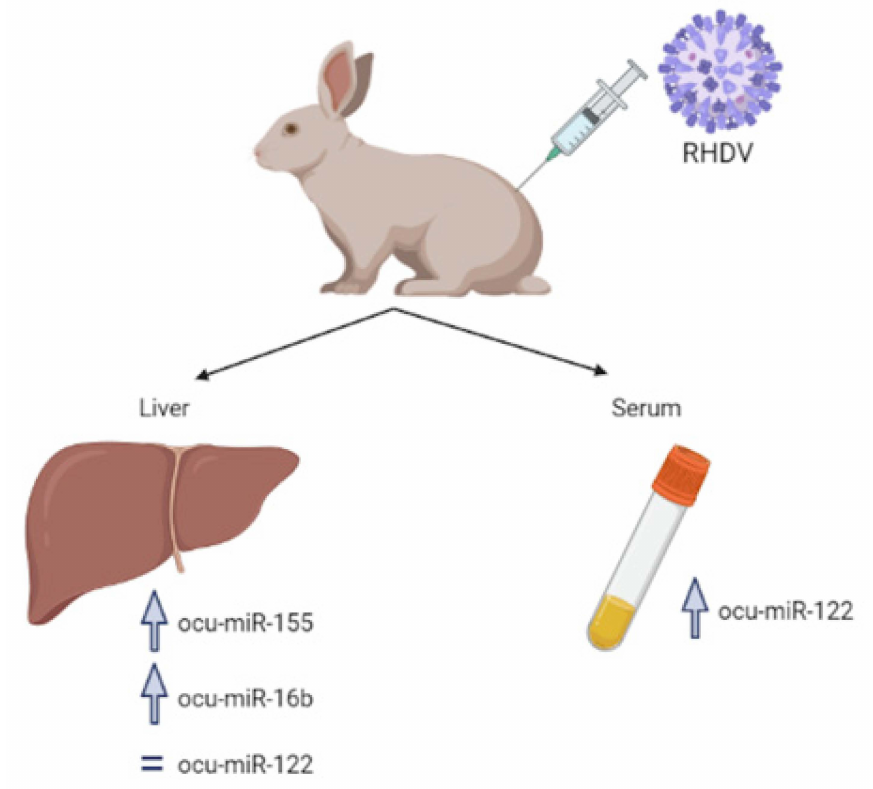
Figure 3. Signature of miRNAs ocu-miR-155-5p, ocu-miR-16b-5p, and ocu-miR-122-5p in the course of Lagovirus europaeus /RHDV infection